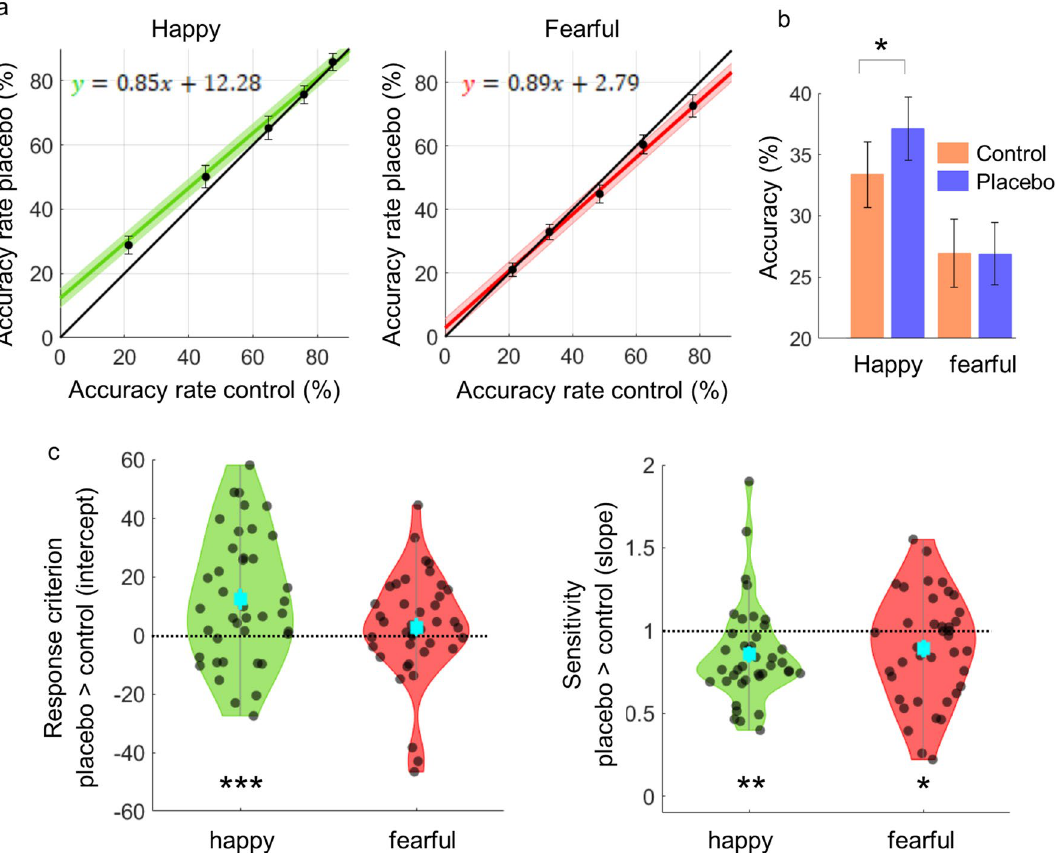
Figure 5. Response criterion and sensitivity in the emotional classification task. ( a ) Psychometric functions: Performance during the placebo condition was regressed onto performance during the control condition (s.e.m. of intercept shown as shaded area, error bars show s.e.m of condition differences at each step of expression intensity). ( b ) Condition differences for lowest 2 steps of expression intensity. Accuracy for happy expressions was greater in the placebo (blue) condition relative to the control (orange) condition specifically at the lower end of the intensity spectrum. No such differences were observed for fearful expressions. Error bars show s.e.m. (c) Distribution of slope and intercept values: The mean intercept for happy faces was significantly greater than zero, indicating a placebo-induced reduced threshold to detect happy faces. Mean slopes values for both emotions were significantly less than one, indicating a reduced ability to discriminate subtle emotional expressions under placebo. Mean and s.e.m are shown in the center of each violin plot. ***p < .001, **p < .005, *p <